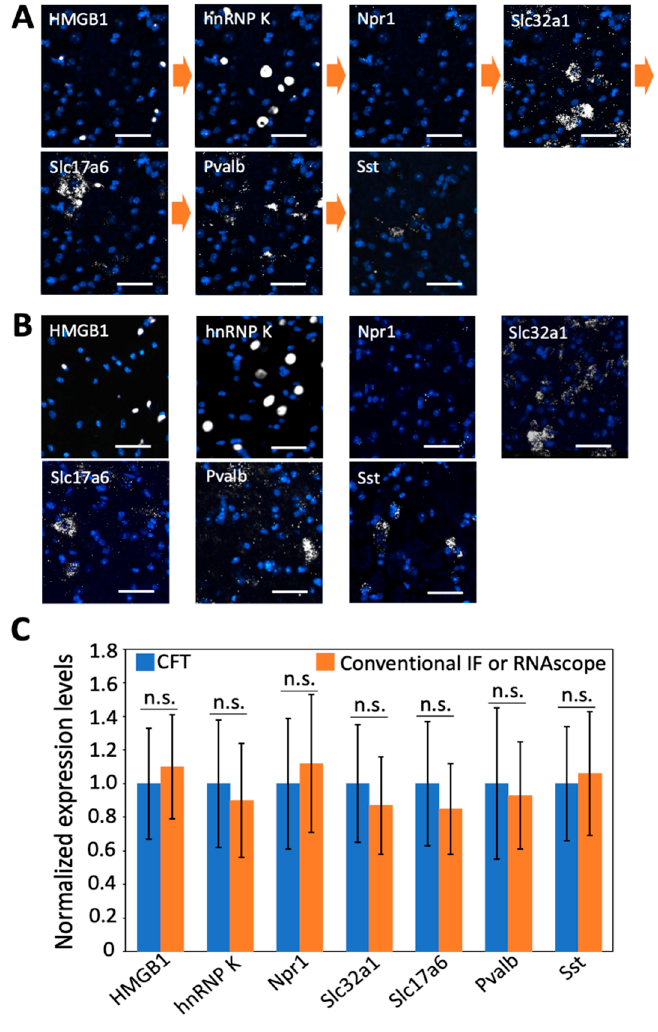
Figure 7. ( A ) Proteins HMGB1 and hnRNP K together with mRNA Npr 1, Slc32a1, Slc17a6, Pvalb, and Sst are stained sequentially with tyramide-N 3 -Cy5 in a fixed frozen mouse spinal cord tissue. ( B ) The same two proteins and five mRNA are stained in seven different fixed frozen mouse spinal cord tissues by conventional immunofluorescence (IF) or RNAscope. ( C ) Comparison of the normalized single-cell expression levels obtained in ( A , B ) ( n = 30 cells). Error bars generated using standard error of the mean. n. s., p > 0.4. Scale bar, 40 µm.